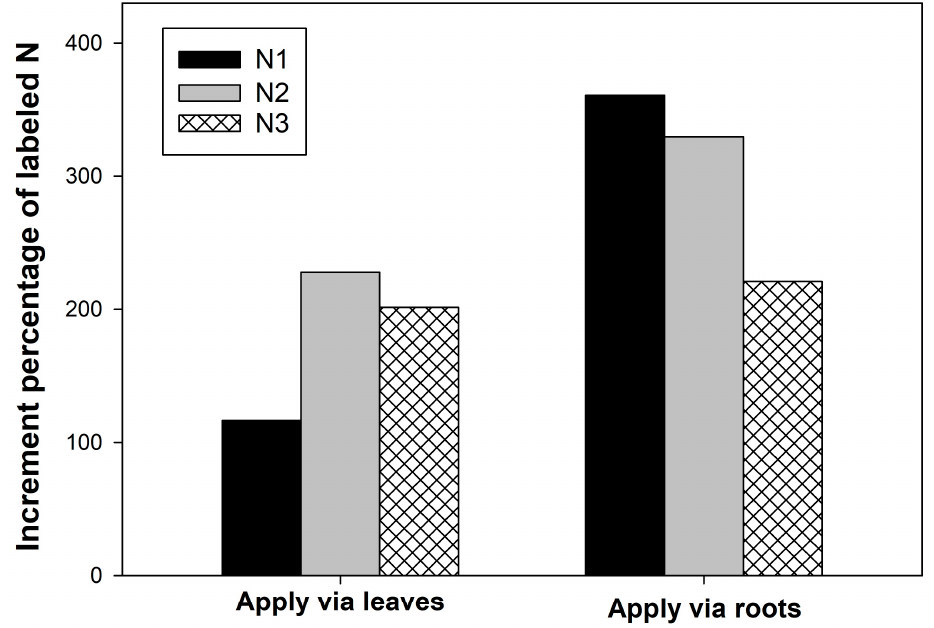
Figure 4. Increment percentage of labeled N in Vanda supplied with different N sources via leaves and roots. (N1 = 2.5 mM 15 NO 3 − + 2.5 mM NH 4 + , N2 = 2.5 mM NO 3 − + 2.5 mM 15 NH 4 + , and N3 = 2.5 mM glutamine).